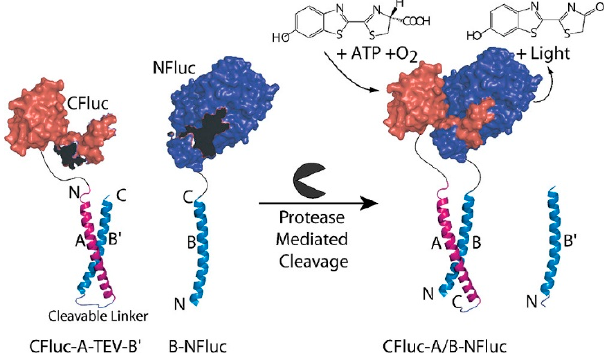
Figure 5. Split protein activation following protease addition. Here the firefly luciferase is separated into a C-terminal (CFluc) and N-terminal half (NFluc), both containing additional helices that can form a coiled-coil to bring both halves together to reconstitute the luciferase. This interaction can only occur when the autoinhibiting coil is released through addition of the tobacco etch virus (TEV) protease. Other reporter proteins can be similarly broken into two halves, including other proteases to generate extended logic cascades. Reprinted with permission from Shekhawat, S.S., Porter, J.R., Sriprasad A., and Ghosh, I. 2009. An autoinhibited coiled-coil design strategy for split-protein